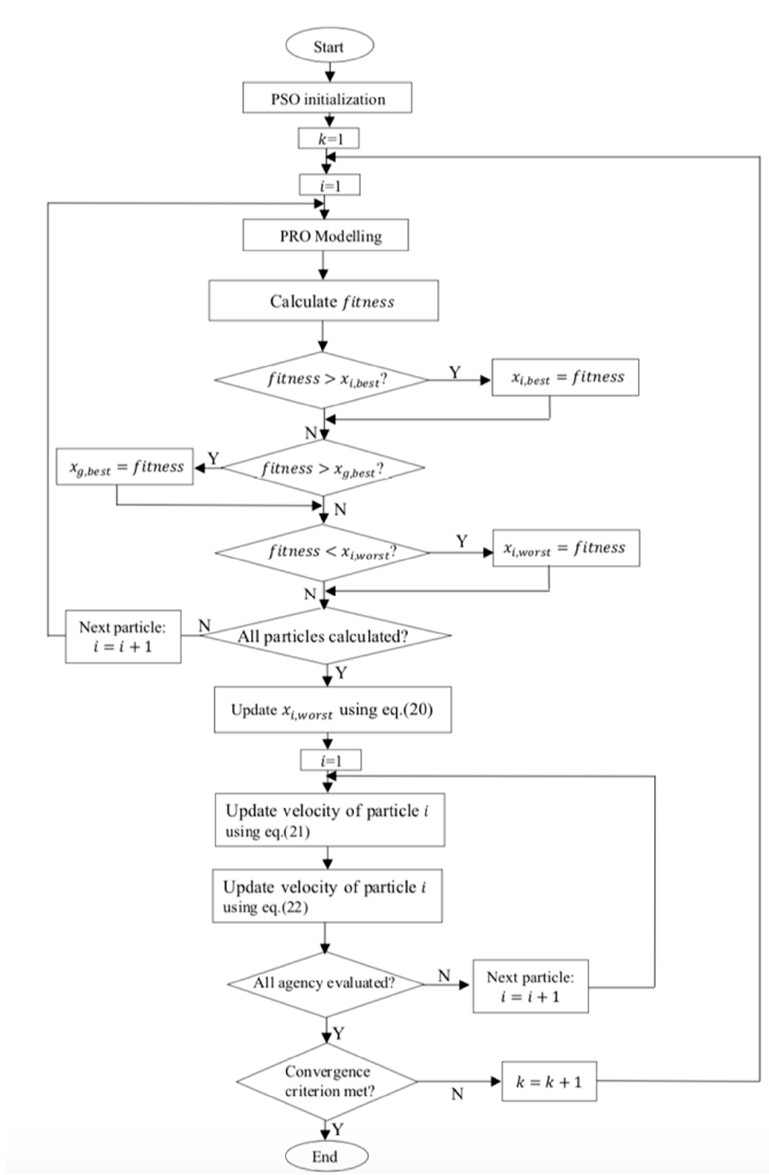
Figure 2. Flow chart of the BPSO-based maximum energy extraction algorithm for the PRO sys- tem.